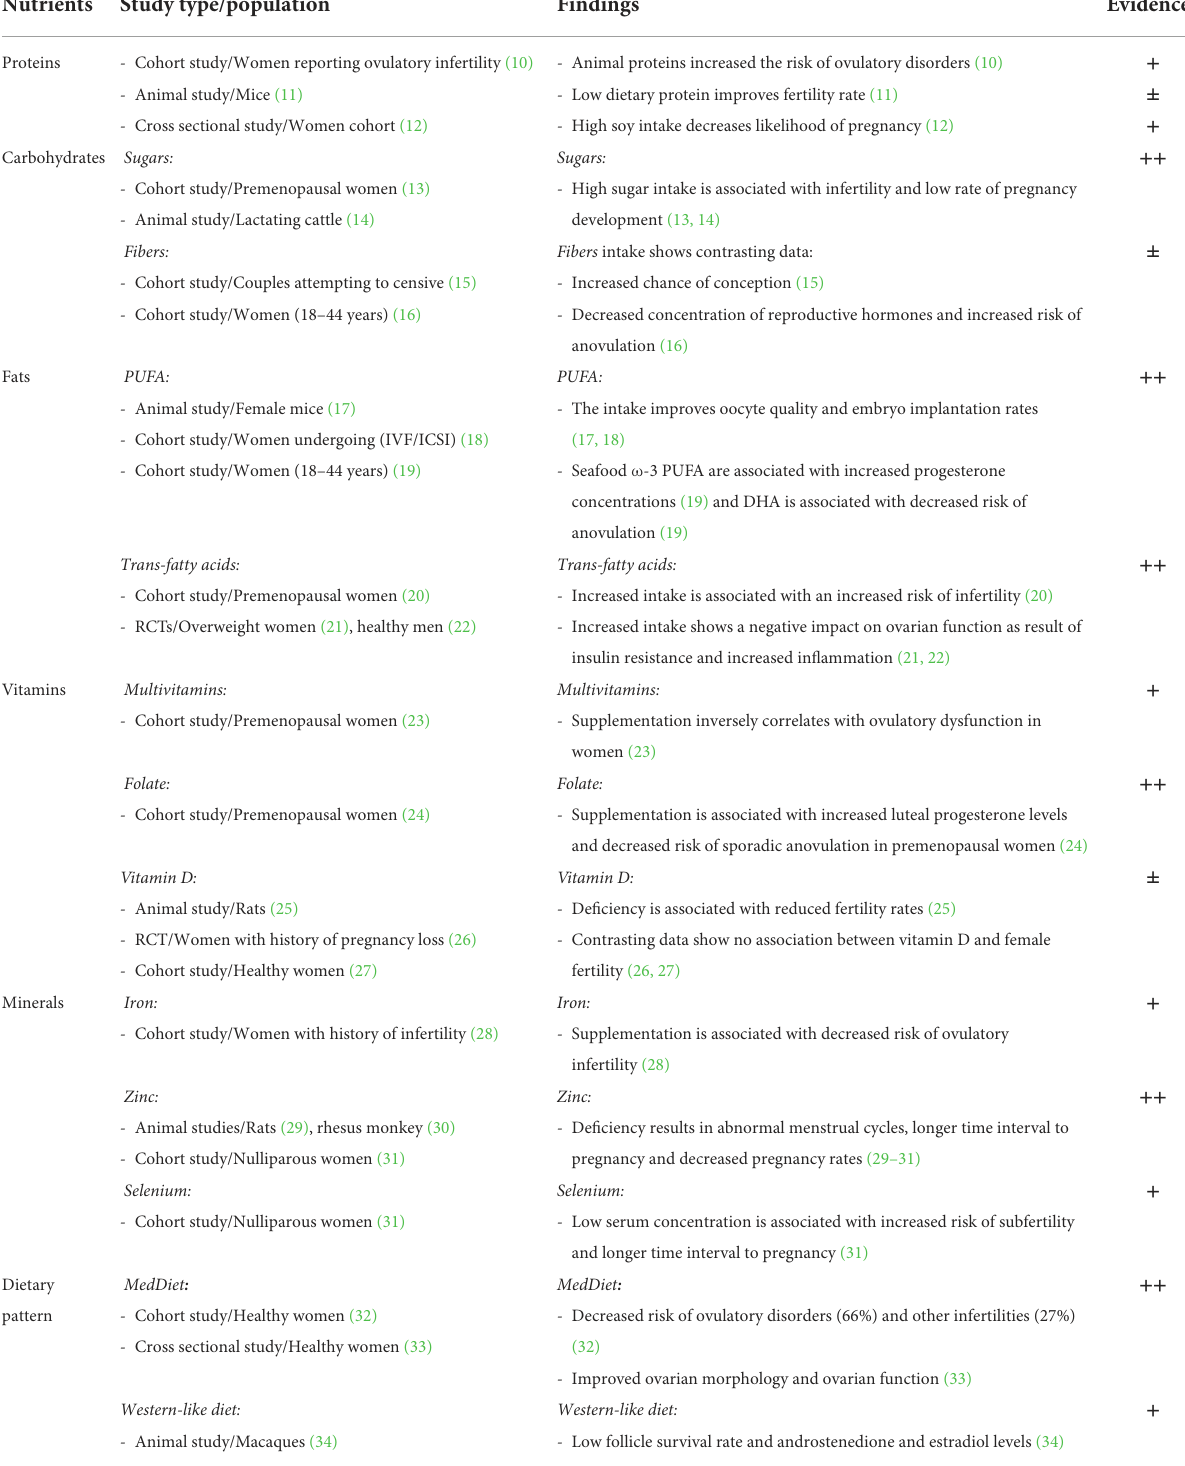
TABLE 1 The effect of several nutritional factors and dietary patterns on female reproductive health. Female reproductive health Nutrients Study type/population Findings Evidence